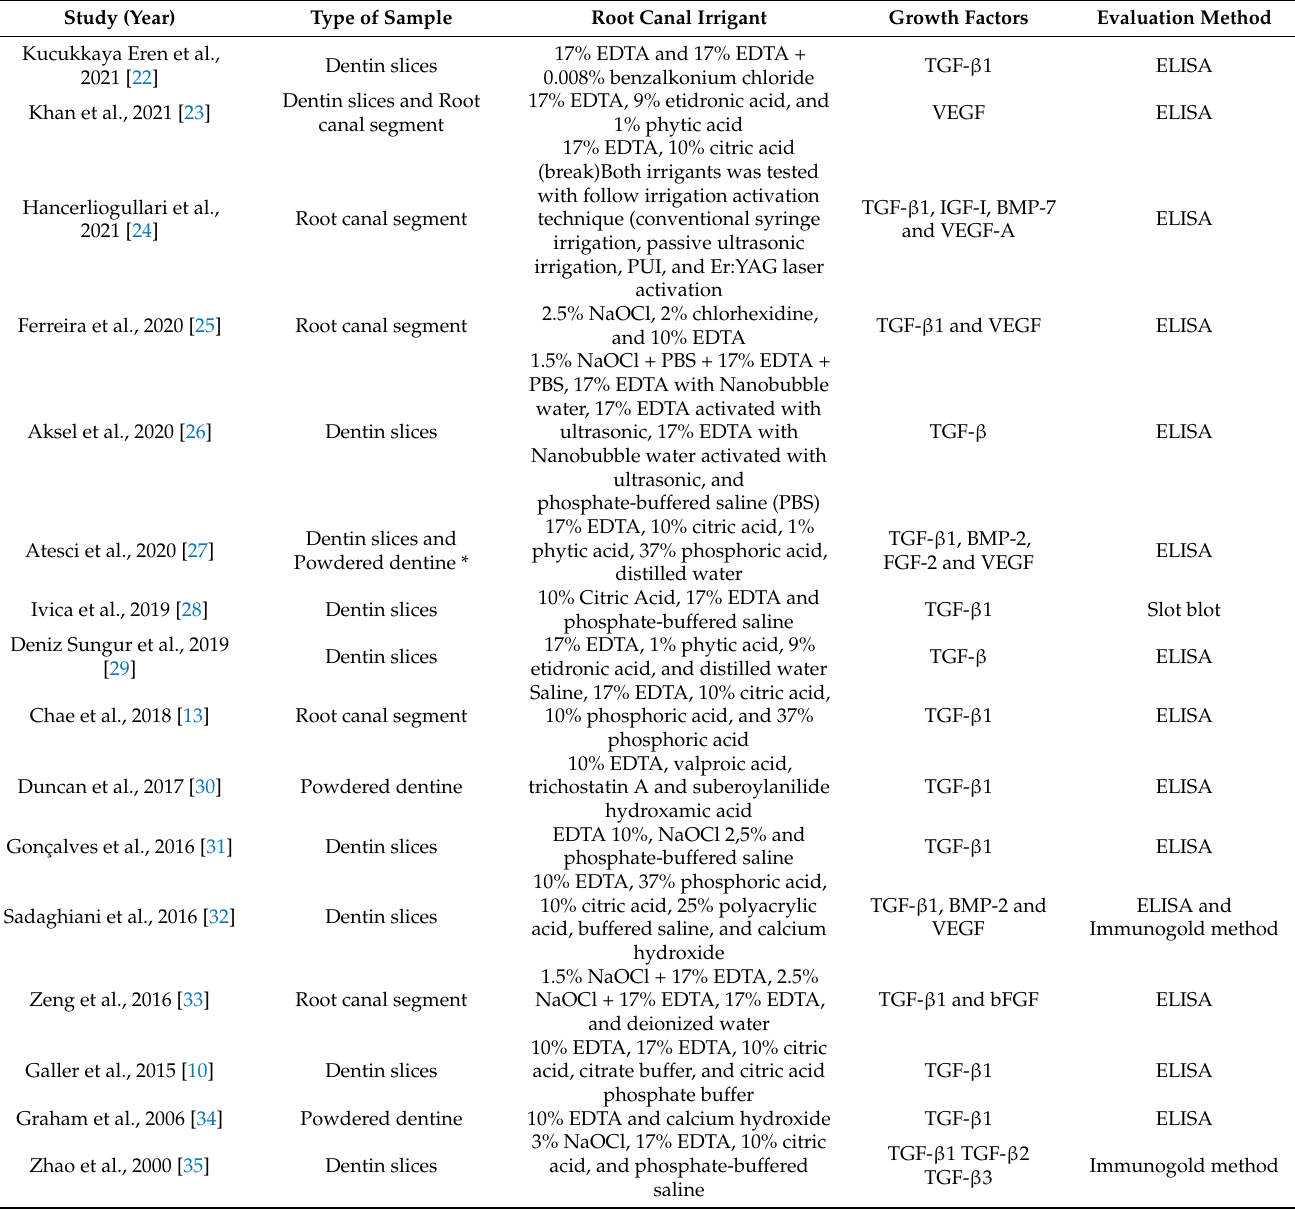
Table 1. Main characteristics of the included